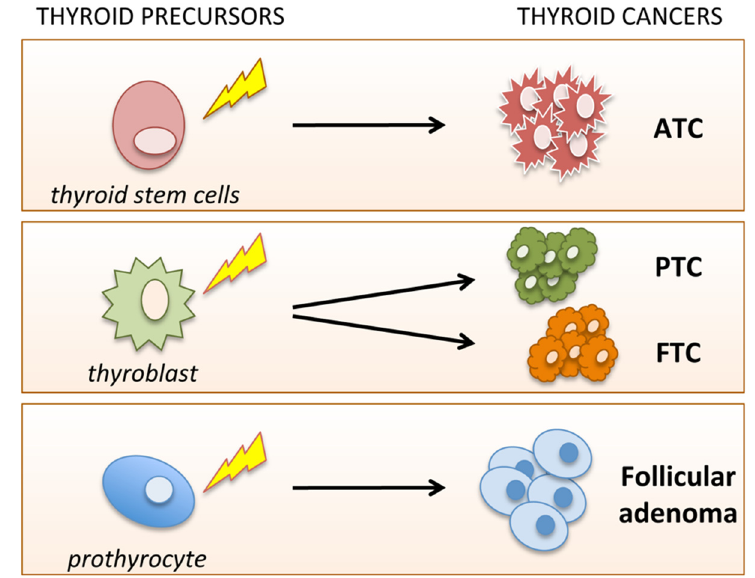
Figure 3. Schematic representation of fetal carcinogenesis in thyroid cancer. According to this model, thyroid cancer cells derive from the transformation of the three types of fetal thyroid cells, namely, thyroid stem cells, thyroblasts and prothyrocytes, which may give rise to ATC, PTC and FTC, and follicular adenoma, respectively.